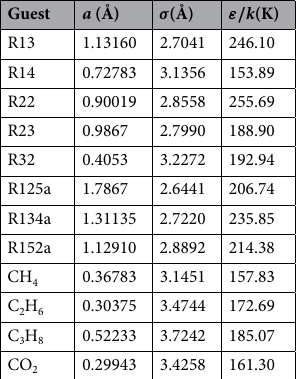
Table 4. Kihara potential parameters regressed to experimental hydrate phase equilibrium data.